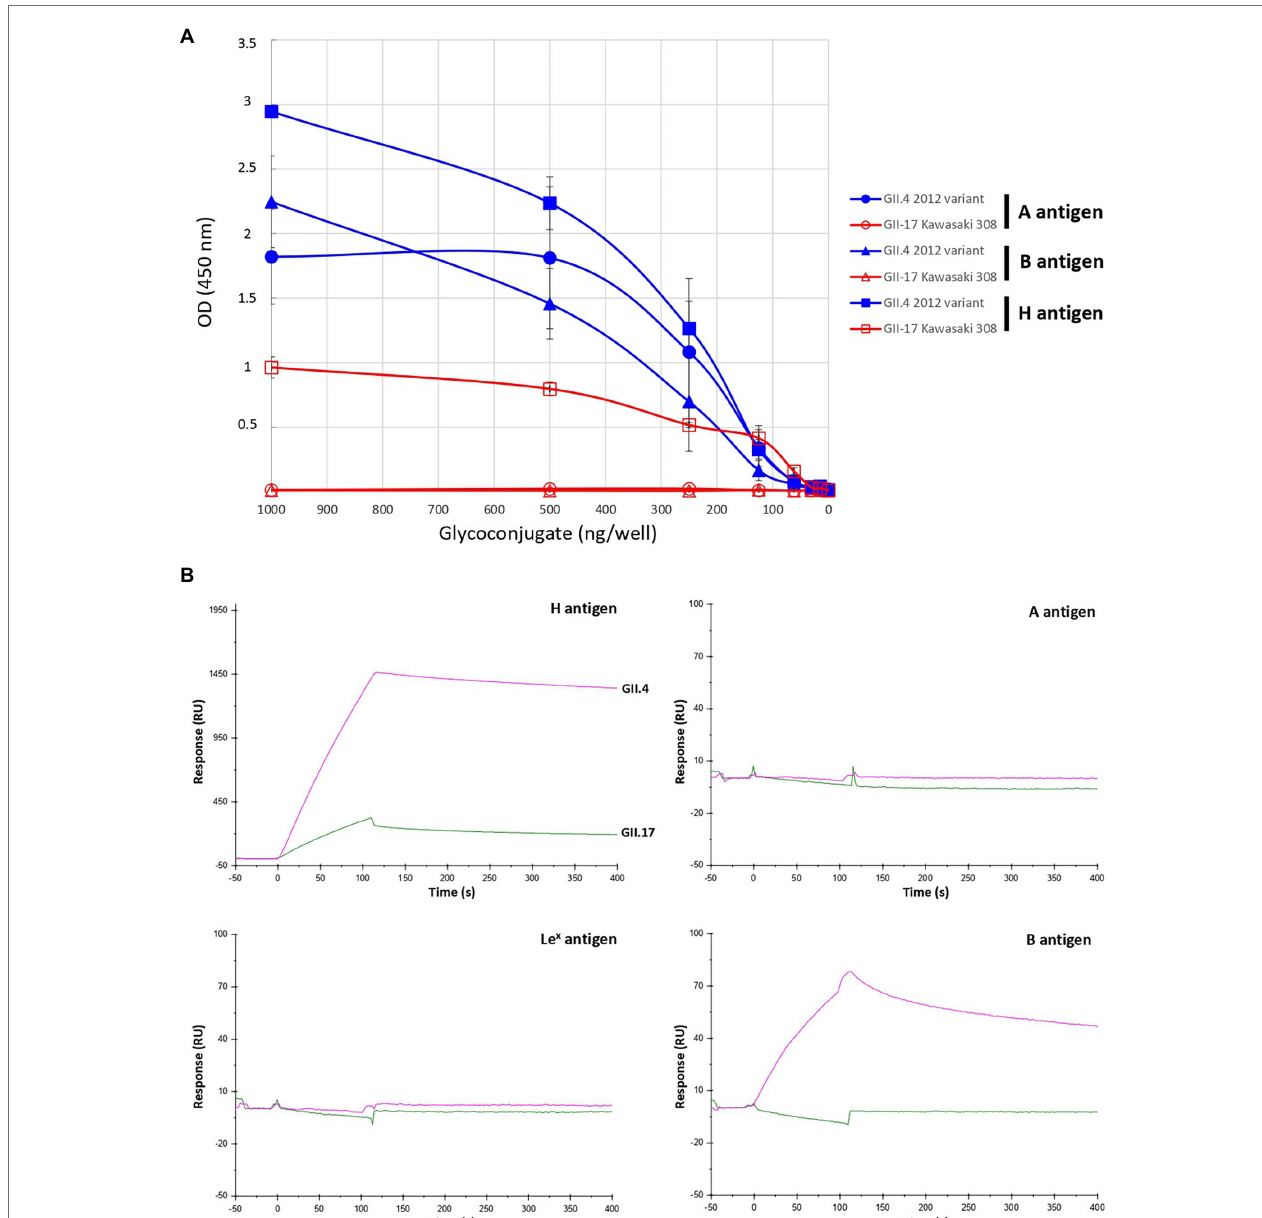
FIGURE 4 | Relative binding of GII.17 Kawasaki 308 variant and GII.4 2012 variant to BSA-conjugated A, B, and H type 1 antigens by ELISA (A) and SPR (B) . For the ELISA binding assay, the conjugated histo-blood group antigen (HBGA) were diluted 2-fold in pH 9.6 carbonate–bicarbonate buffer from 1,000 to 15 ng per well. BSA-conjugated A, B, and H (LNFP-I) antigens are indicated by circle, triangle and square, respectively. The quantity of conjugated carbohydrates is indicated below the graph. HBGA and VLP genotypes for each experiment are indicated on the right side of the graph. Values are given in optical density at 450 nm wavelength (ordinate). Each binding experiment was performed in triplicate and the mean results are given with standard deviations (vertical bars). For the SPR binding assay, the same VLP and neoglycoconjugate preparations were used as for the ELISA. The response (ordinate) is given in resonance units (RU). The time (abscissa) is given in second (s). The first 120 s ( t = 0 s through t = +120 s) correspond to the time of injection of the VLP. The sensorgram is color-coded for each variant, the name of which is indicated on the curves corresponding to the H antigen sensorgram. Pink and green curves correspond to the use of GII.4 (2012 variant) and GII.7 VLP (Kawasaki308 variant), respectively. The synthetic glycoconjugates used for the experiments are indicated on the upper right corner of each